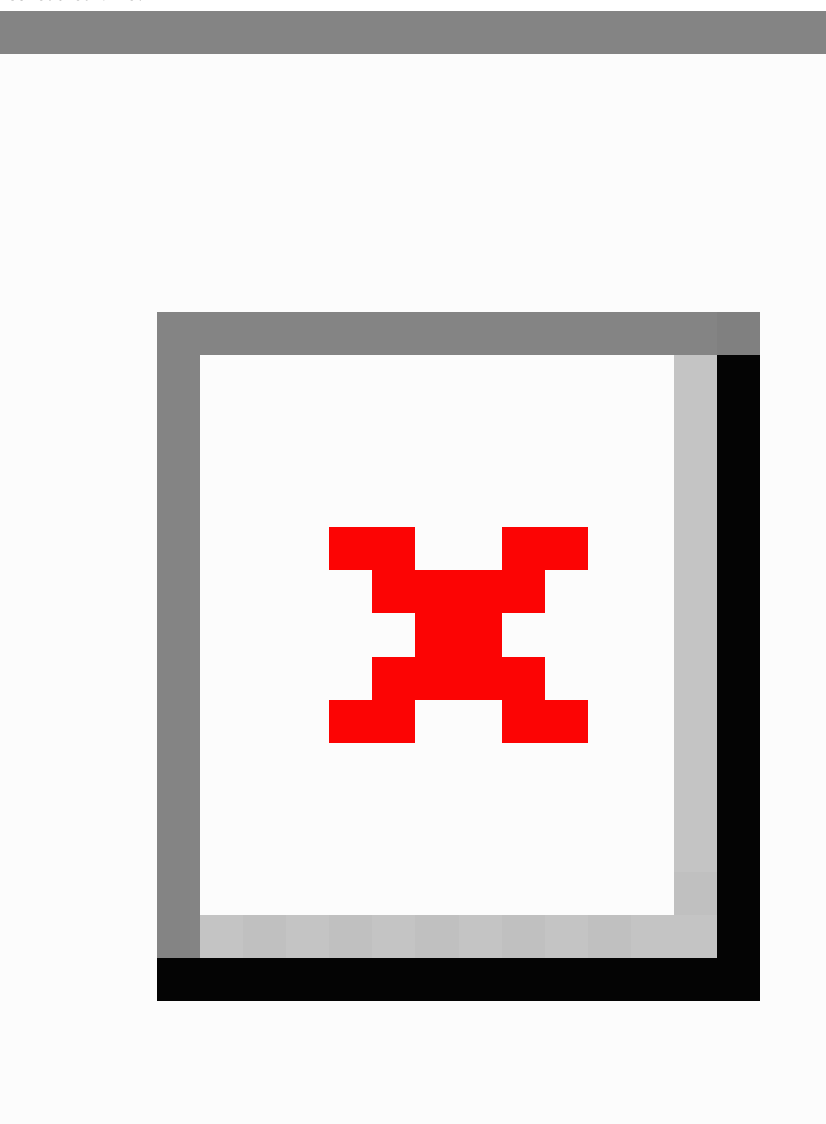
Figure 4. Mean timing adherence rates of 221 users of the Perx app over 3 months. The users were considered to be adherent to the dose if it was taken within ±1 hour of the scheduled